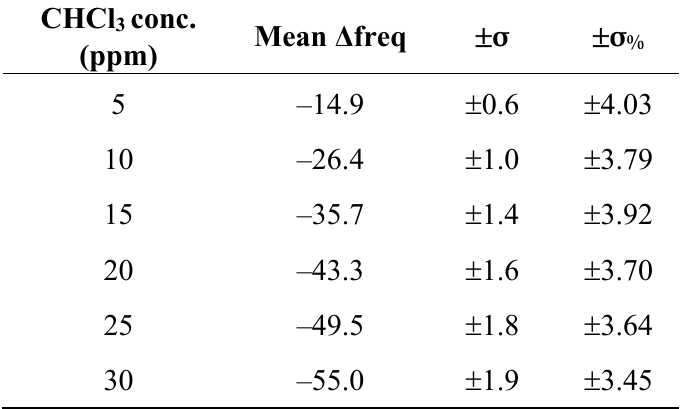
Table 1. Mean and standard deviation for experimental equilibrium response of QCM